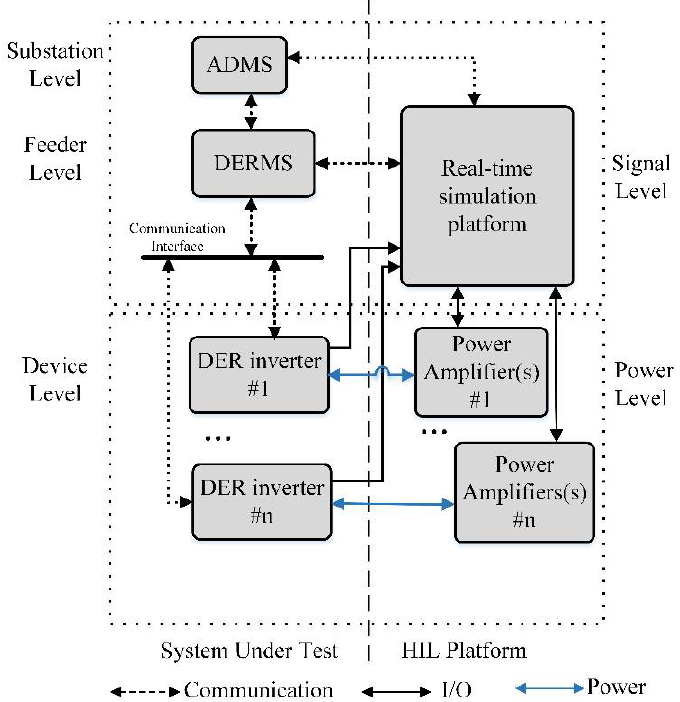
Figure 1. Generic schematic diagram of the HIL platform for testing the distribution automation